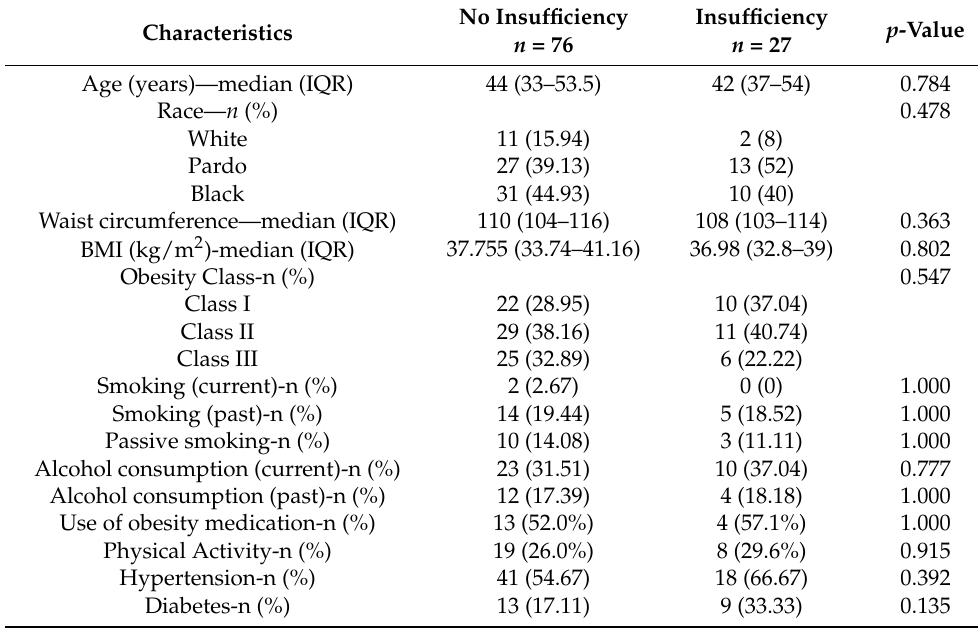
Table 1. Clinical and biochemical characteristics of the population by 25(OH)D